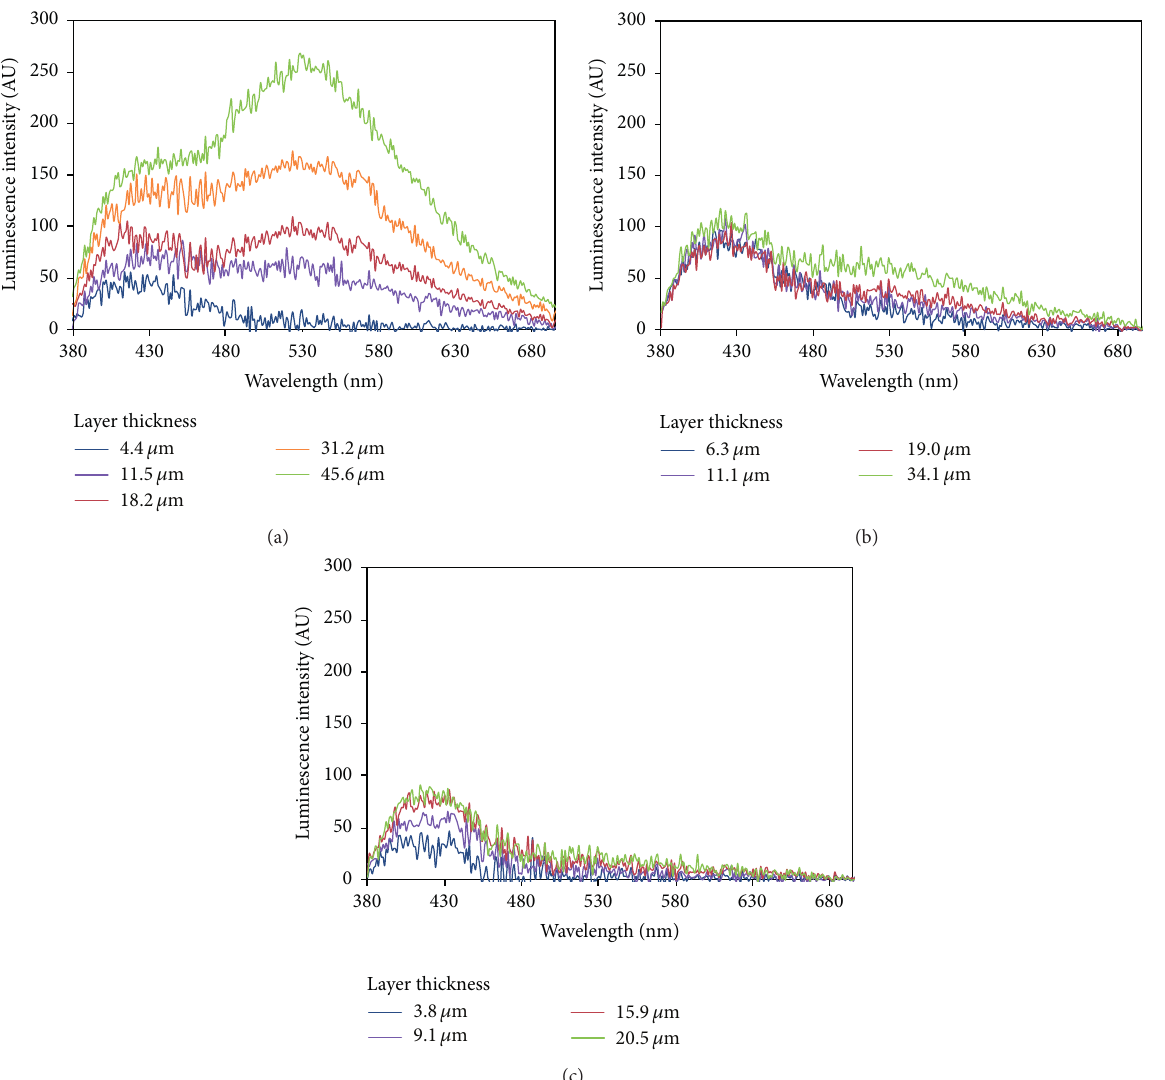
Figure 5: The own luminescence spectra of images printed onto the paper with the minimum content of OBAs (paper 1) using the ink compositions with the following contents of the fluorescent component (ZnO nanoparticles): (a) 0.15%; (b) 0.1%; (c)